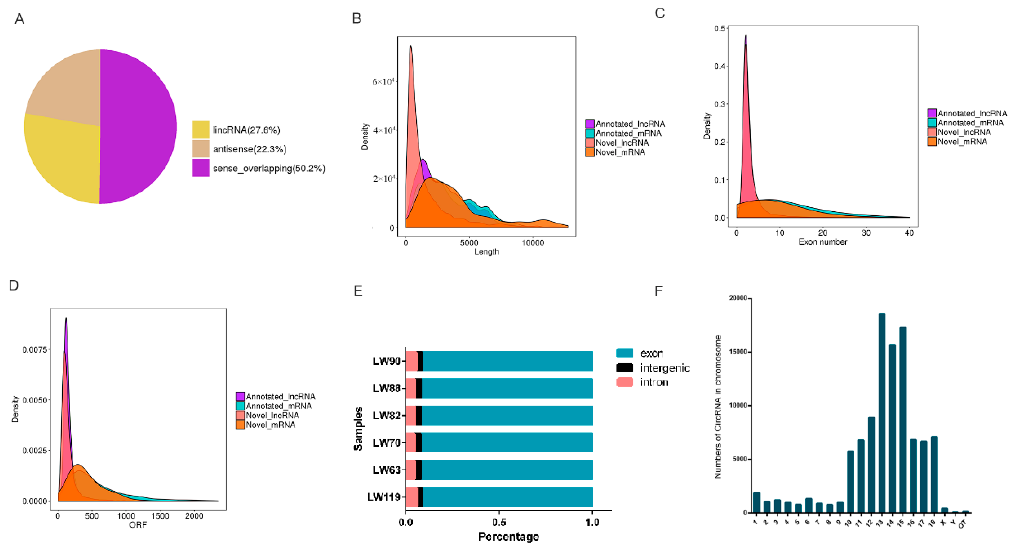
Figure 1. Characteristics of lncRNAs and circRNAs. ( A ) Summary of lncRNA types; ( B ) comparison of transcript size distribution; ( C ) comparison of exon number; ( D ) comparison of ORF length; ( E ) summary of circRNAs types; ( F ) the distribution of circRNA on the genomic location.